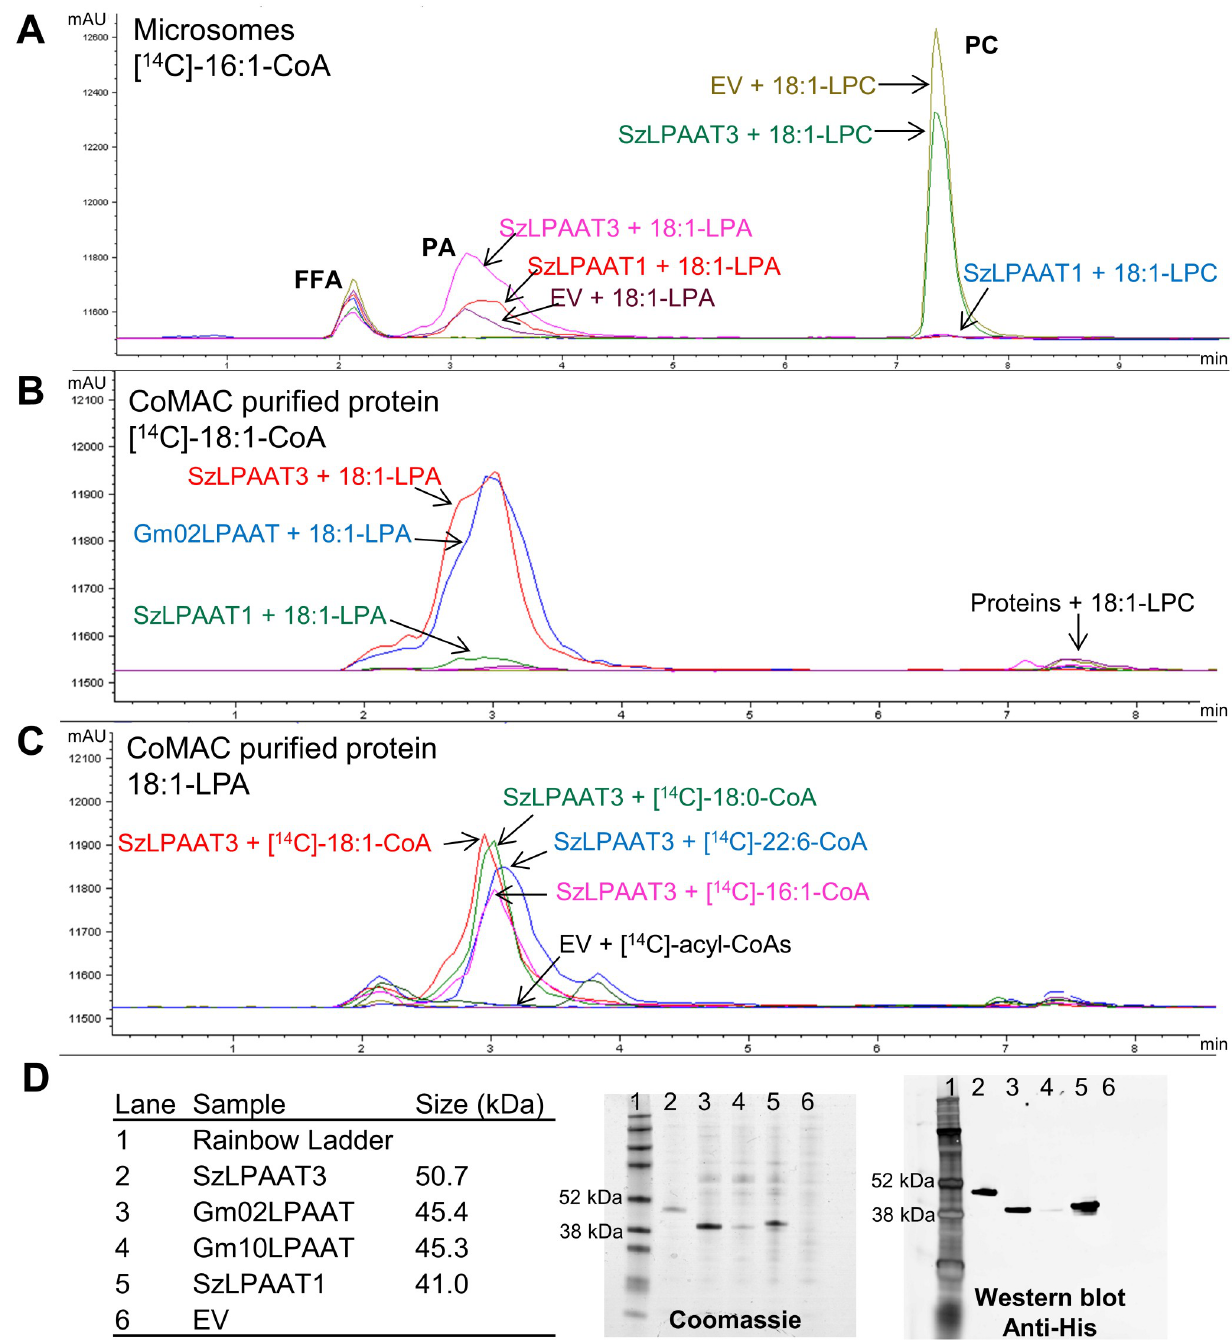
Fig 2. In vitro enzyme assays with putative LPAAT proteins expressed in Baculovirus-transfected insect cells. (A) Chromatogram overlay of extracts from microsomal prepared fraction assayed with [ 14 C]-16:1-CoA using either 18:1-LPA or 18:1-LPC substrate. PC, phosphatidylcholine; PA, phosphatidic acid; FFA, free fatty acid. (B) Chromatogram overlay of extracts from CoMAC purified proteins assayed using [ 14 C]-18:1-CoA and 18:1-LPA substrates. (C) Chromatogram overlay of extracts from CoMAC purified SzLPAAT3 compared with empty vector (EV) controls assayed with four different radiolabeled acyl-CoA substrates. (D) Coomassie blue-stained SDS-PAGE gel and western blot of CoMAC purified proteins.